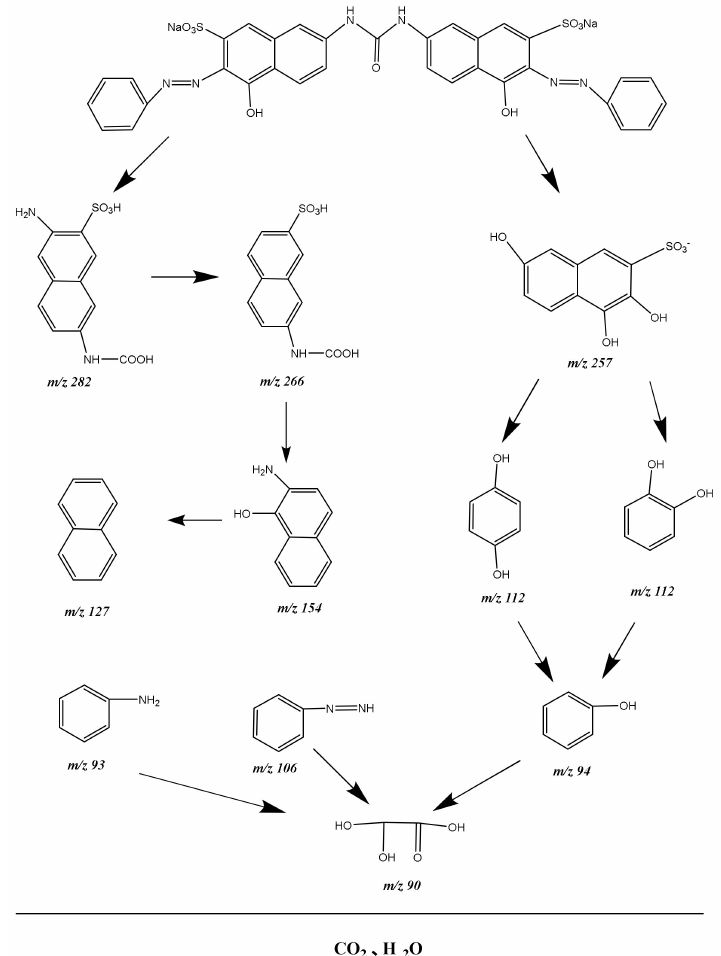
Figure 22. Suggested PD pathway scheme for DO under VLI with Bi 2 SmSbO 7 /ZnBiYO 4 heterojunc- tion as